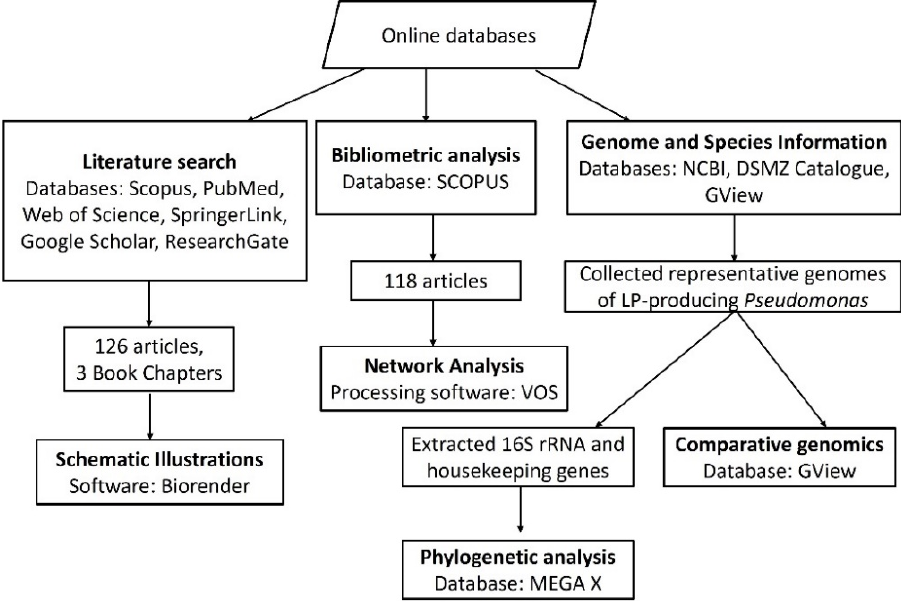
Figure 1. A detailed flow chart diagram describing the databases used and the study selection process.